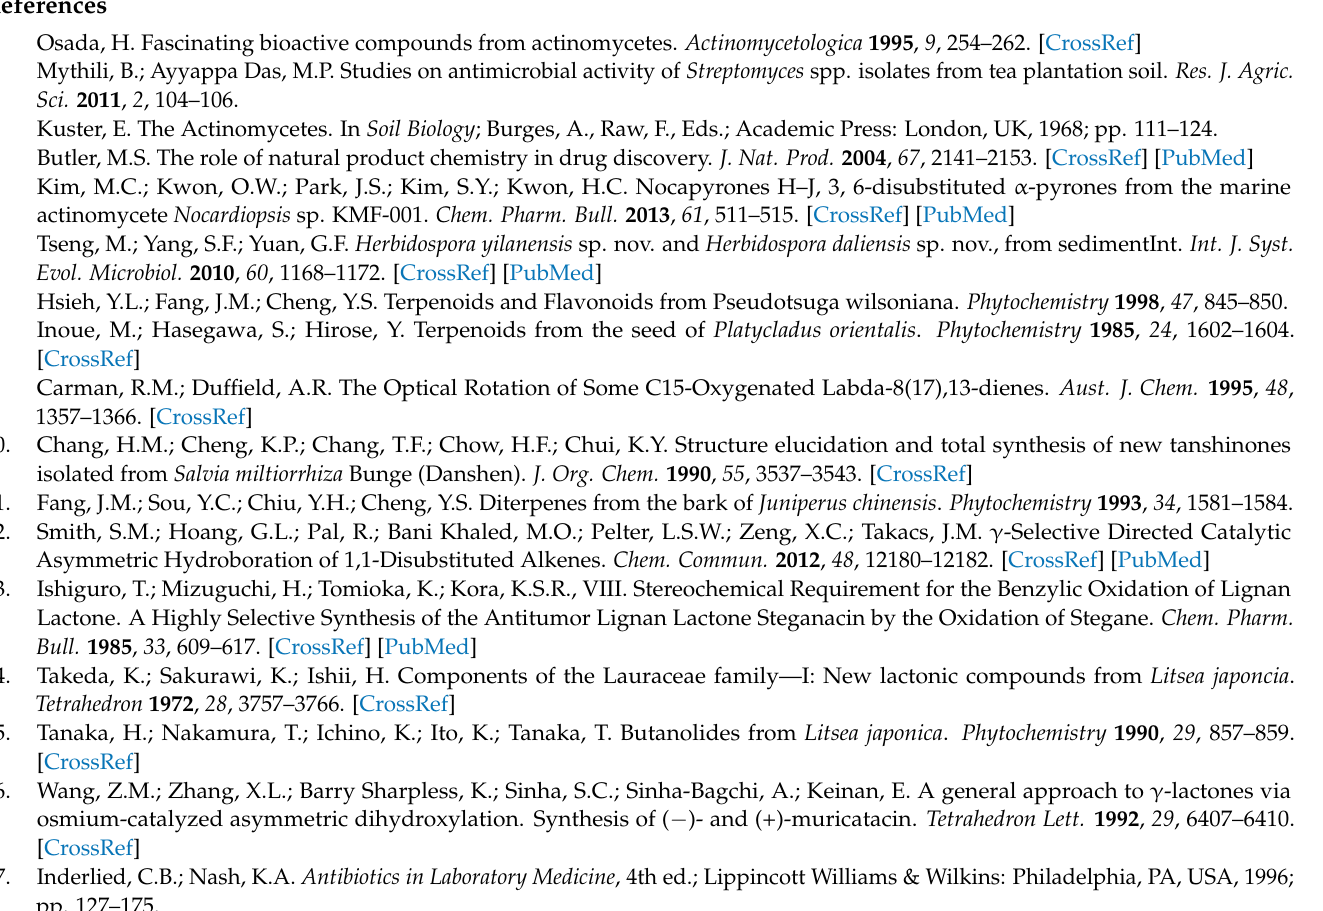
NMR spectrum of 9; Figure S58. 13C NMR/DEPT spectra of 9; Figure S59. 1H-1H COSY spectrum of 9; Figure S60. HMBC spectrum of 9; Figure S61. NOESY spectrum of 9; Figure S62. HSQC spectrum of 9; Figure S63. EI-MS spectrum of